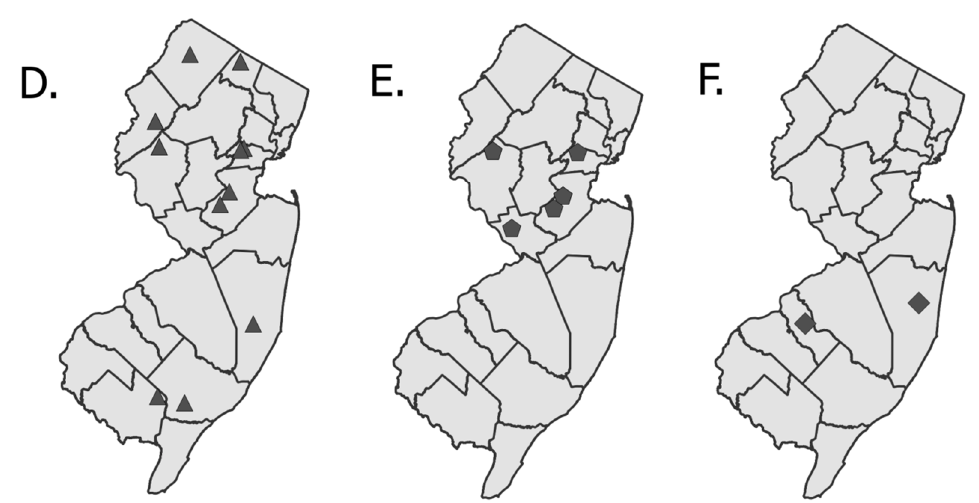
Figure 3. Map of New Jersey plotted with ( A ) all 51 sites sampled for the 2018 Tick Blitz; and ( B – F ) Sites where each tick species was collected: ( B ) Dermacentor variabilis (Total of 498 ticks); ( C ) Amblyomma americanum (238 ticks); ( D ) Ixodes scapularis (37 ticks); ( E ) Haemaphysalis longicornis (36 ticks); ( F ) Haemaphysalis leporispalustris (2 ticks).